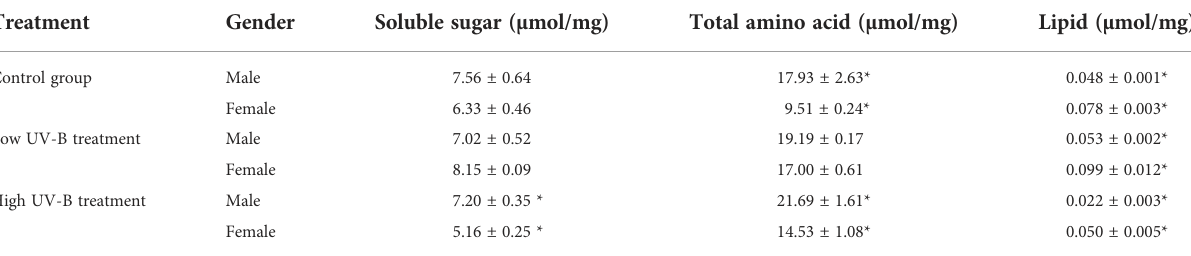
TABLE 2 Amount of soluble sugar, total amino acid, and lipid in male and female S. thunbergii under different conditions.